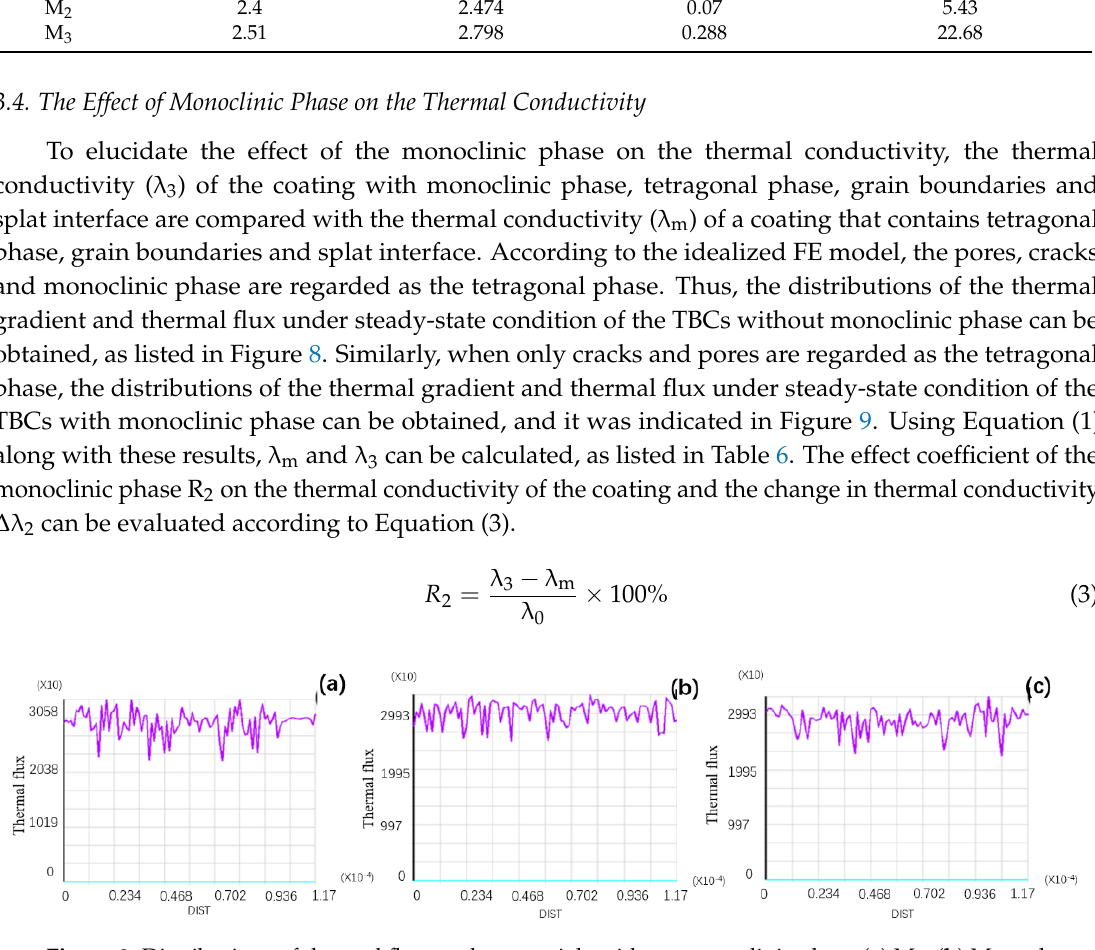
Figure 9. Distributions of thermal flux on the materials with monoclinic phase ( a ) M 1 , ( b ) M 2 and ( c ) M 3 . The amount of monoclinic phase in each coating is listed in Table 3. The monoclinic phase has a very small concentration of 2% in coatings M 1 and M 2 , and the thermal conductivity of the coating is increased by 0.1 W/m·K correspondingly according to Table 7. Furthermore, comparing M 2 with M 3 when the concentration of the monoclinic phase is increased by 6%, the value of the thermal conductivity with monoclinic phase increased by 0.28 W/m·K. Thus, it can be concluded that the monoclinic phase can increase the thermal conductivity of the coatings. The reason is that the content